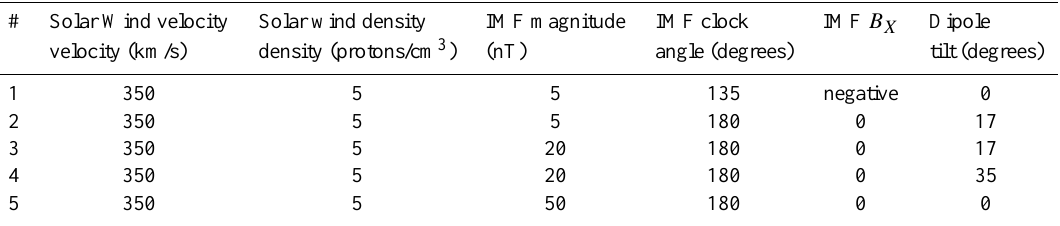
Table 1. Simulation input parameters.